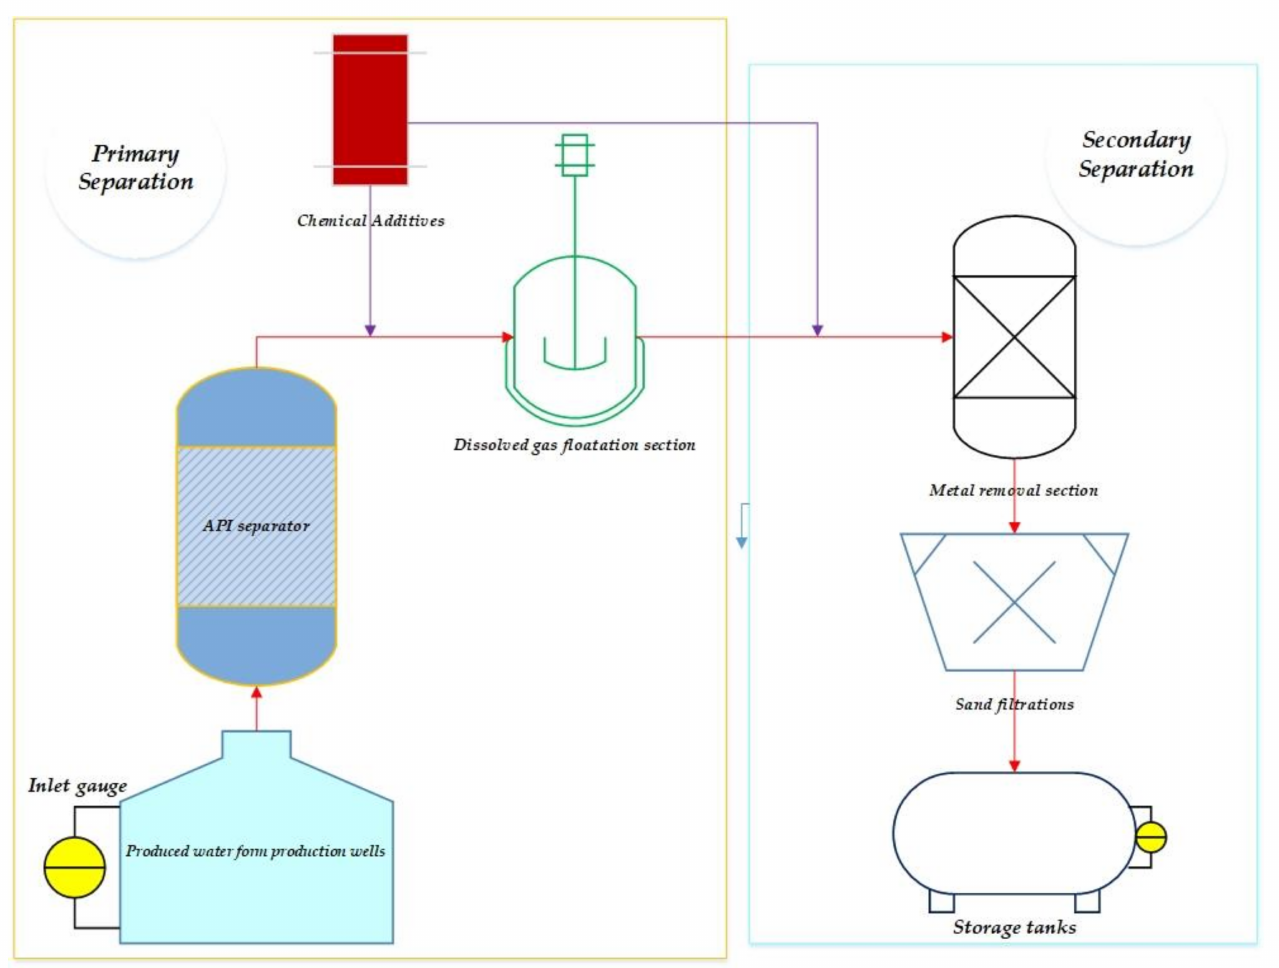
Figure 1. PFF method to retreat produced